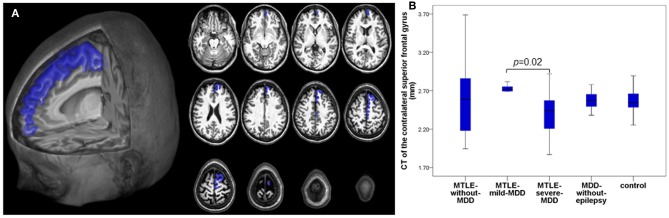
Composition panel illustrating CT reduction in the contralateral superior frontal gyrus (blue). (A) 2D and 3D automated FreeSurfer segmentation of the contralateral superior frontal gyrus. (B) CT of the contralateral superior frontal gyrus among the groups. CT, cortical thickness; MTLE, mesial temporal lobe epilepsy; MDD, Major Depressive Disorder; MTLE-without-MDD, MTLE patients without depression; MTLE-mild-MDD, MTLE patients with mild symptoms of depression; MTLE-severe-MDD, MTLE patients with moderate to severe symptoms of depression; MDD-without-epilepsy, patients without epilepsy with MDD.